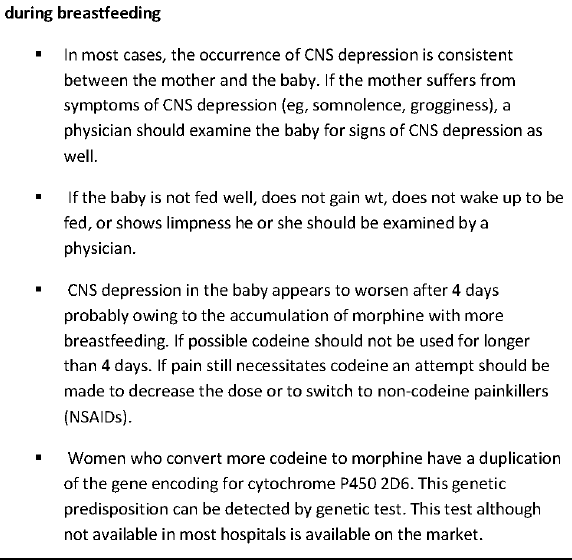
Figure 1. Safety guidelines for codeine use during breastfeed- ing. Motherisk safety guidelines for codeine use in breastfeeding pamphlet given to all expectant mothers with planned caesarean sections at St. Michaels Hospital in Toronto, Ontario, Canada (14). Women were advised to take codeine for as short a period as possible (3–4 days postpartum) and were advised to seek the care of a physician if they required pain medication beyond this point. Mothers were also advised to breastfeed before taking codeine to maximize the time to eliminate codeine in between feeds. (cid:2) Motherisk Program and The Hospital for Sick Children. Reprinted with permission from the Canadian Family Physician.